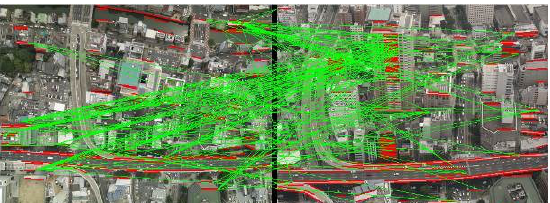
Figure 12 . Extracted line segments in nadir image